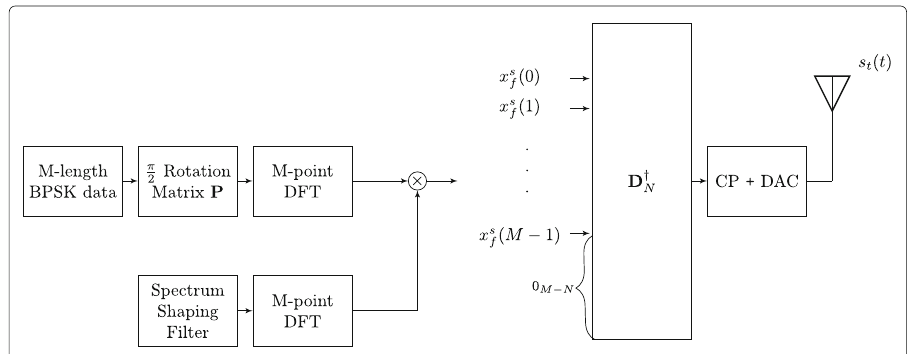
Fig. 6 Transmitter architecture for data waveform generation using method 1